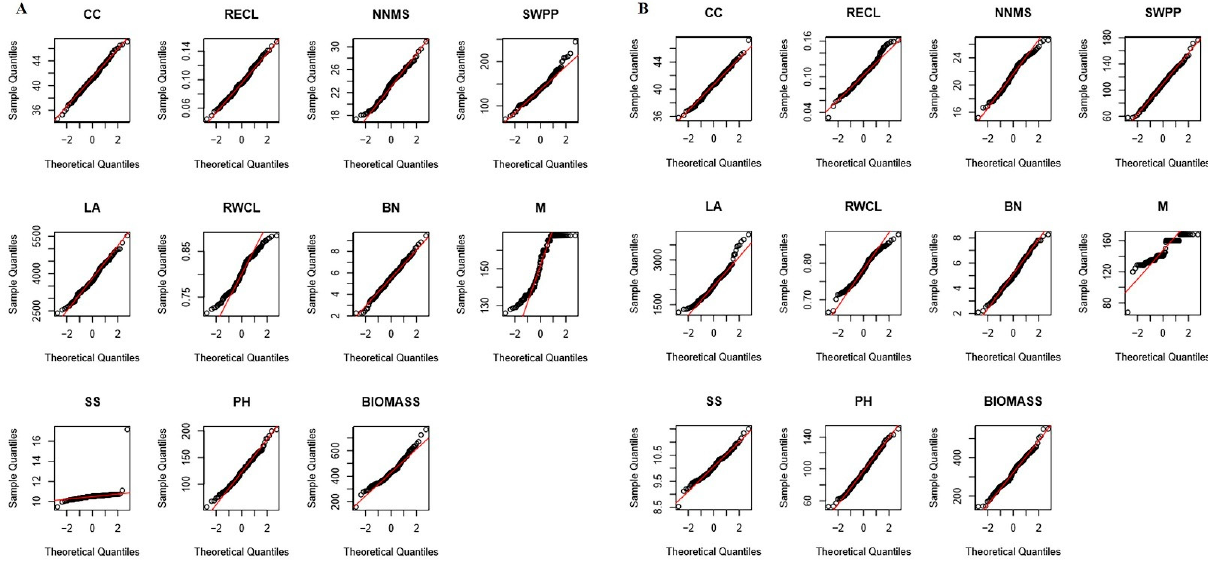
Figure 1. The QQ chart of normal distribution of 11 traits in 162 RILs under well-watered and drought stress conditions. ( A ) Distribution of traits under well-watered condition. ( B ) Distribution of traits under drought stress. LA, leaf area; PH, plant height; BN, branch number; CC, chlorophyll content; RWCL, relative water content of leaves; RECL, relative electric conductivity of leaves; NNMS, node number of main stem; BIOMASS, biomass; SWPP, seed weight per plant; PS, pull stem; M, maturity. The intercept of the red line is the mean and the slope is the standard deviation. Table 1. Mean squares and significant tests after combined analysis of variance for nine agronomic traits under two water regimes.